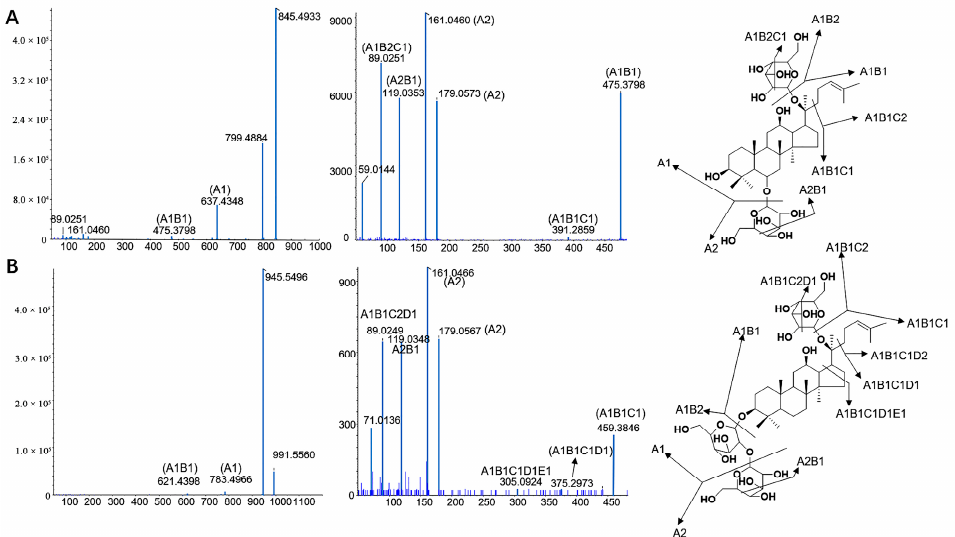
Figure 3. The MS/MS spectra and fragmentation process of Rd ( A ) and Rg1 ( B ).